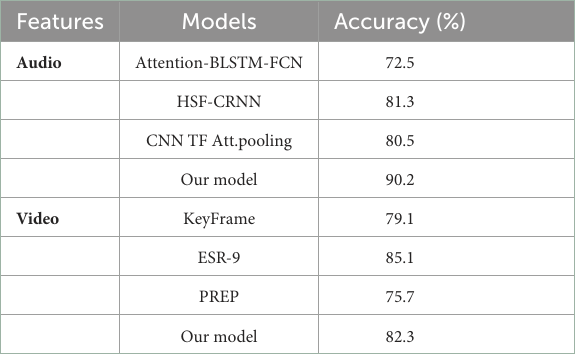
TABLE 2 Performance comparison with other